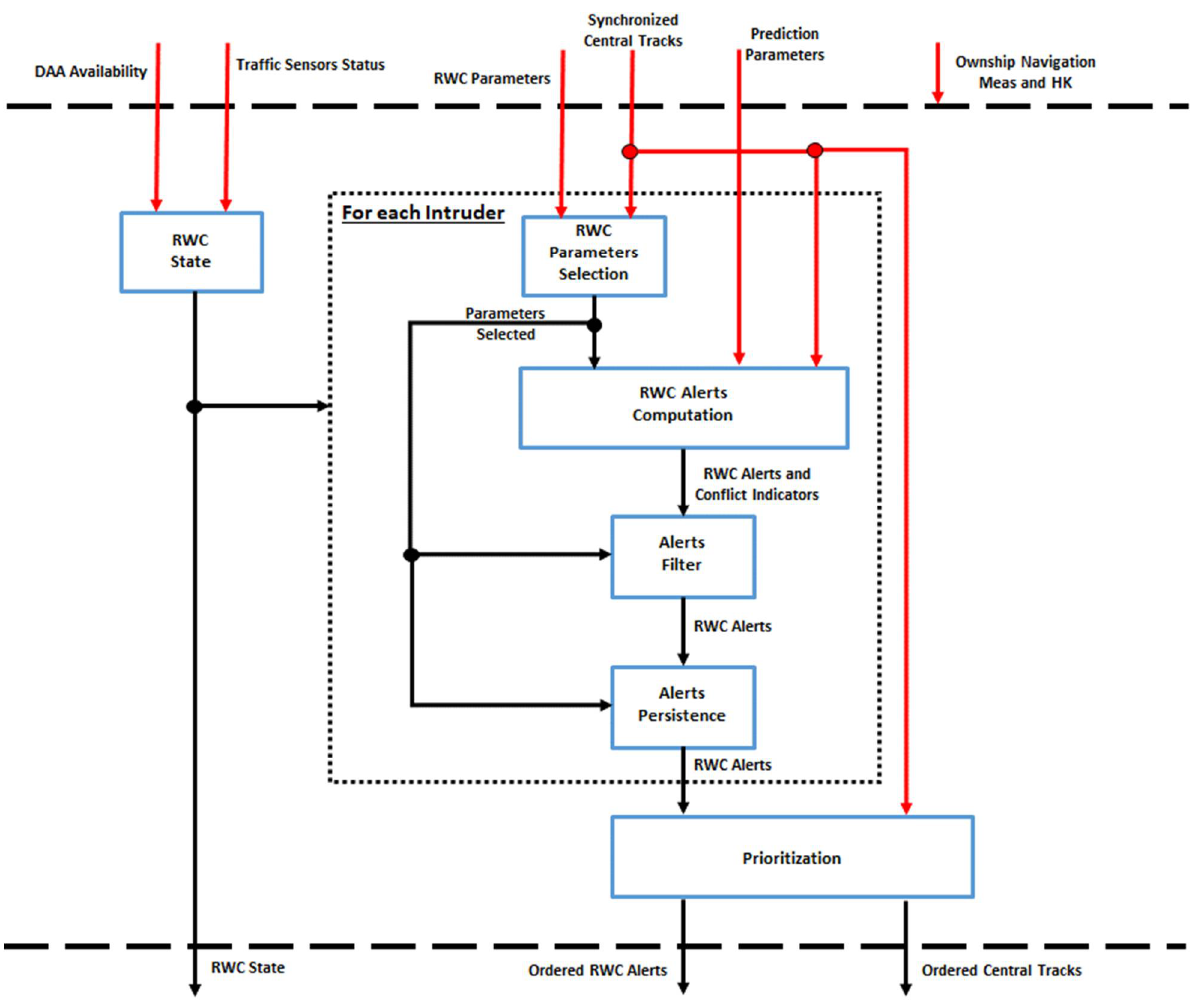
Figure 7. RWC Alerting module detailed architecture.